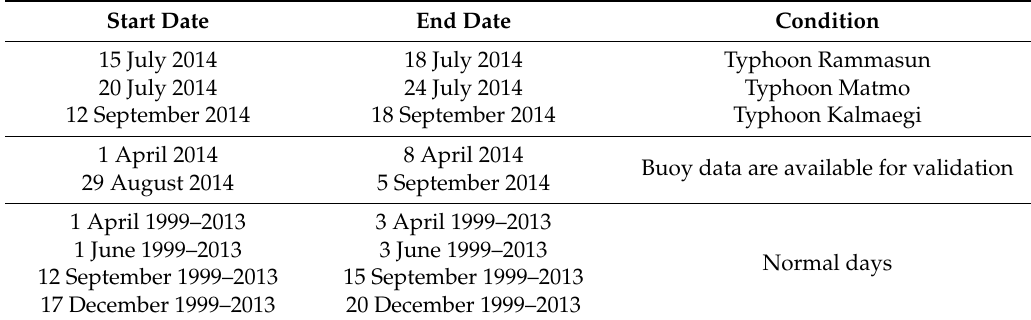
Table 4. The start and end point of the time period under typhoon conditions and non-typhoon